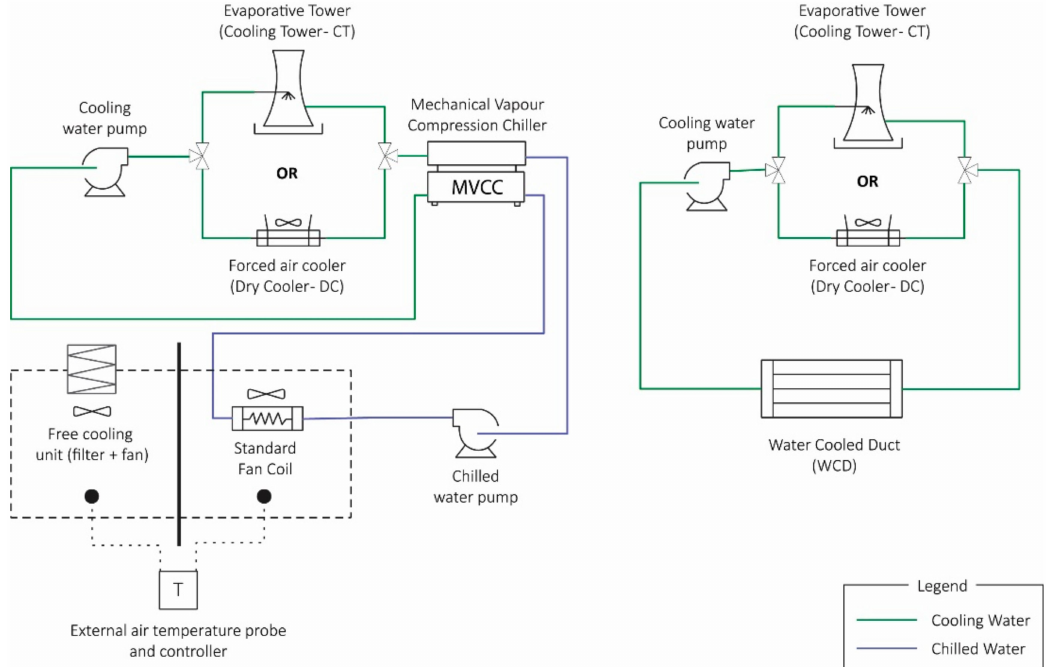
Figure 2. Mechanical vapour compression chiller with free cooling system schematic diagram.